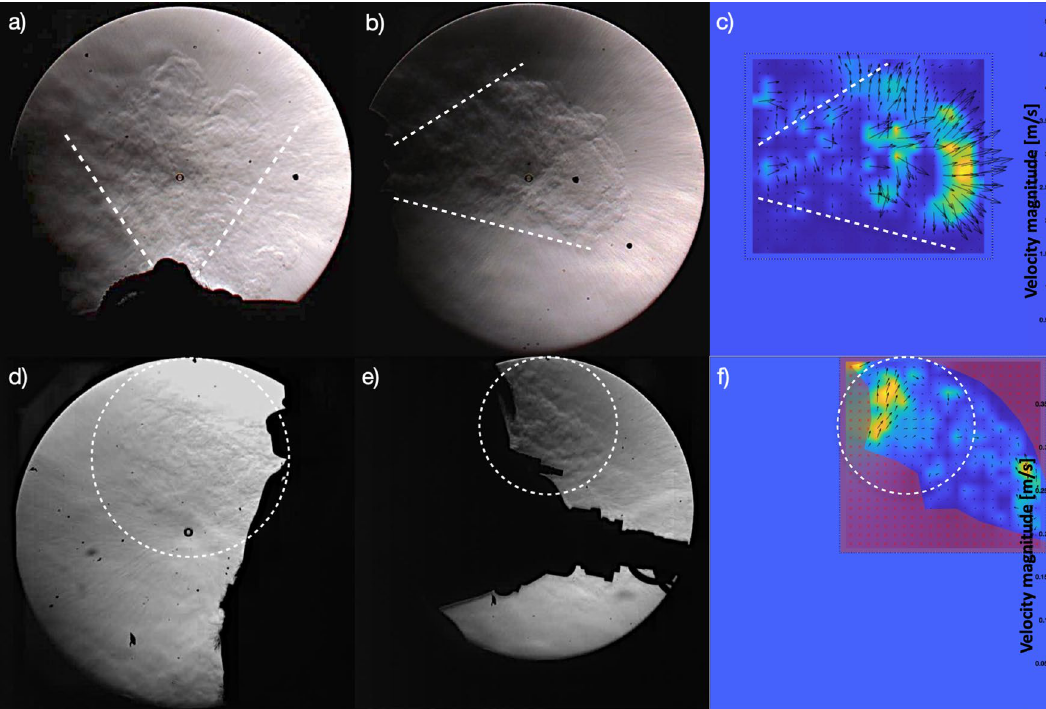
Figure 2. Qualitative and quantitative results from schlieren images of a volunteer’s cough with High Flow Nasal Canulae (HFNC) at 60L/min (top) and with Continuous Positive Airway Pressure (CPAP) at 30L/min (bottom): ( a , d ) View from above with the mouth on the bottom side; ( b , e ) Side view with the mouth on the left side; ( c , f ) Instantaneous velocity magnitude vectors collected through Particle Image Velocimetry (PIV) processing of the ‘side view’ video frames. For HFNC, there are exhaled air speed maximas of 5 m/s at the wave front. For CPAP, leaked air speed maximas reach 0.4 m/s. Air flows, and thus aerosol shedding, depend on the oxygenation technique: they are much more extensive with HFNC than with CPAP. Video sequences are provided in the Supplementary